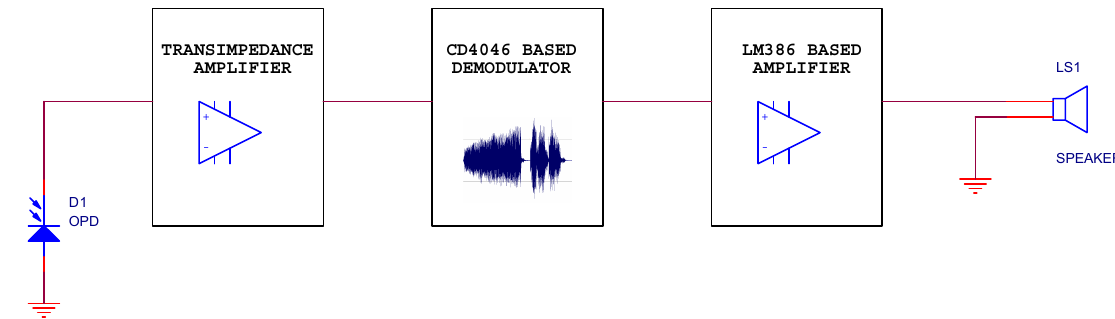
Figure 5. The low-cost VLC receiver circuit block diagram.